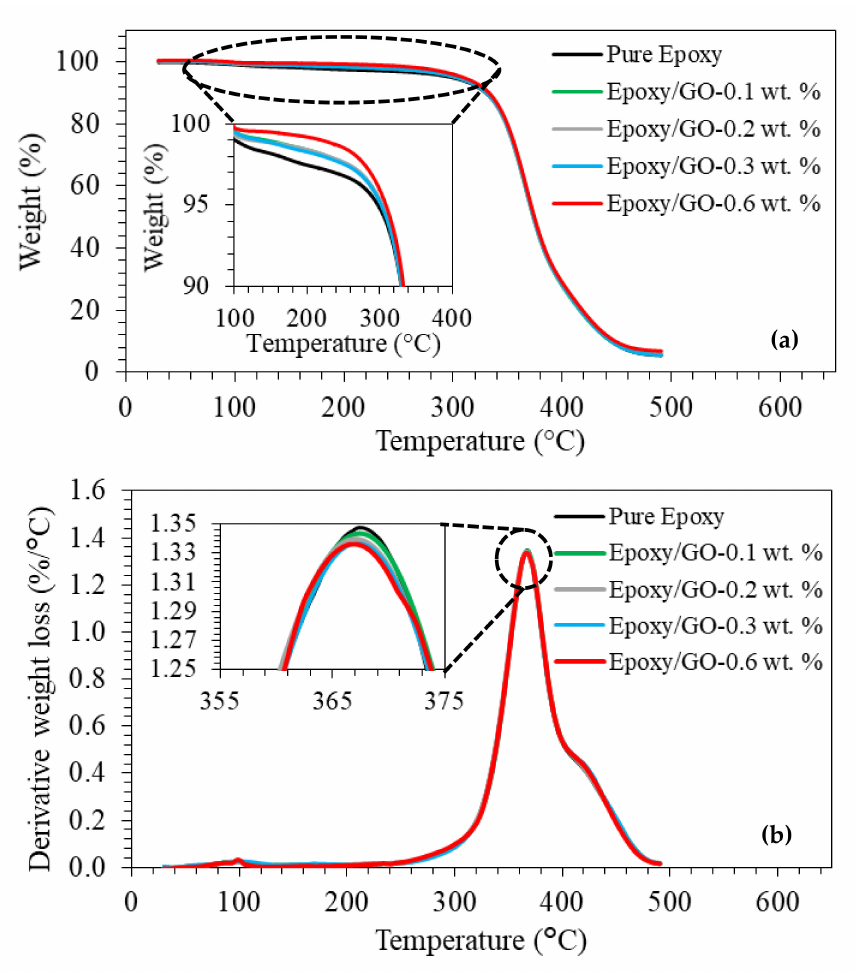
Figure 10. ( a ) Thermogravimetric analysis (TGA) and ( b ) Differential thermal gravimetry (DTG) for